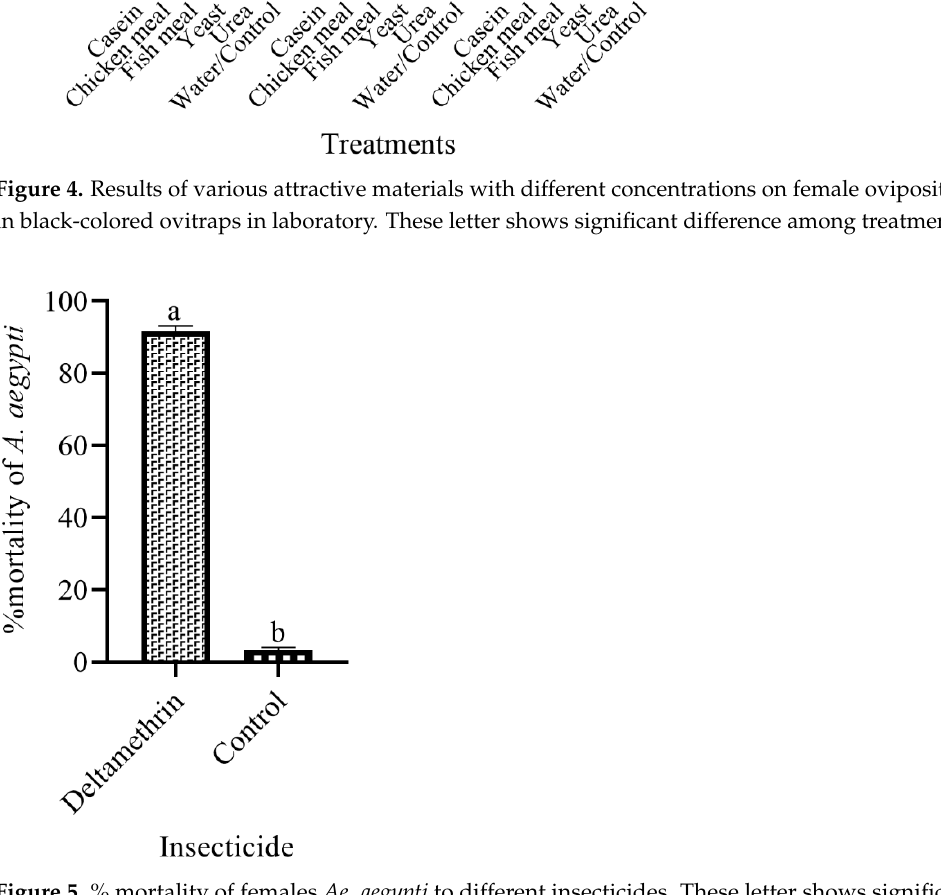
Figure 4. Results of various attractive materials with different concentrations on female oviposi- tion in black-colored ovitraps in laboratory. These letter shows significant difference among treat- ments.